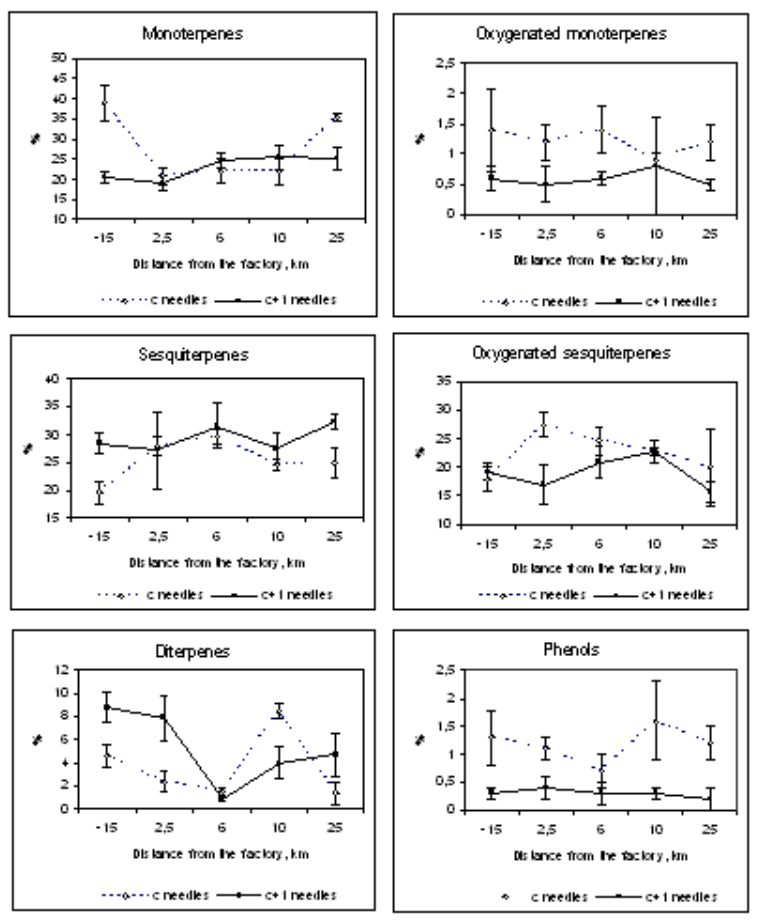
FIGURE 3. Percentage composition (mean values, n = 4) of the main classes of essential oils (monoterpenes, oxygenated monoterpenes, sesquiterpenes, oxygenated sesquiterpenes, diterpenes, phenols) in current-year (c) and 1-year-old (c+1) needles of Scots pine ( P. sylvestris L.) stands growing at different distances from the nitrogen fertilizer factory (July 10, 2005). Error bars indicate an interval of 95%